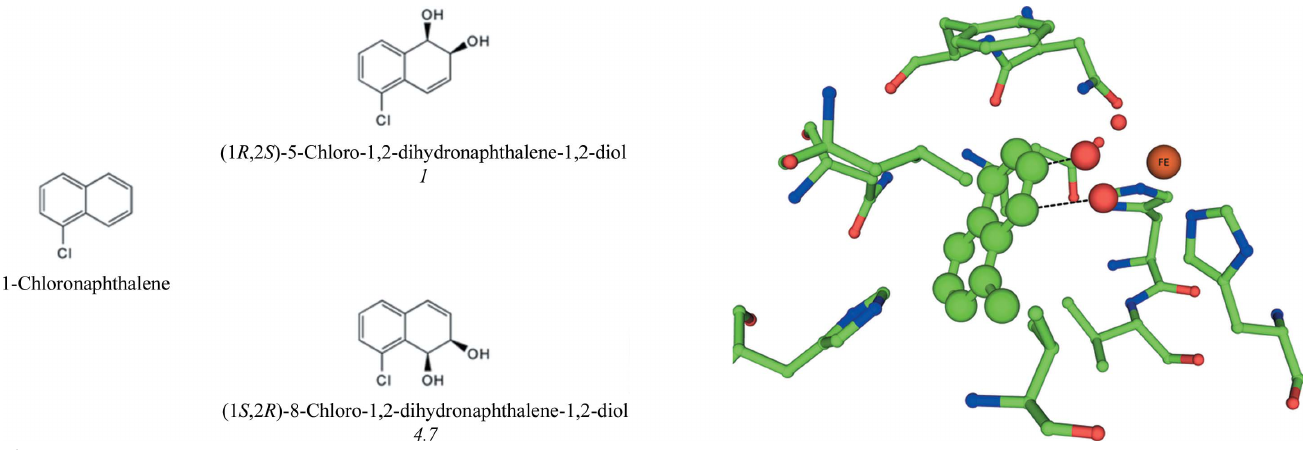
Figure 4 Products formed by NDO with chloronaphthalene. Approximate ratios of products detected in biotransformation assays are shown in italics below the products. Wild-type NDO in complex with chloronaphthalene is shown in green. Active-site residues of NDO are represented by sticks with green C atoms. The mononuclear iron (large orange sphere) and modeled dioxygen from PDB entry 1o7n (small red spheres) are also